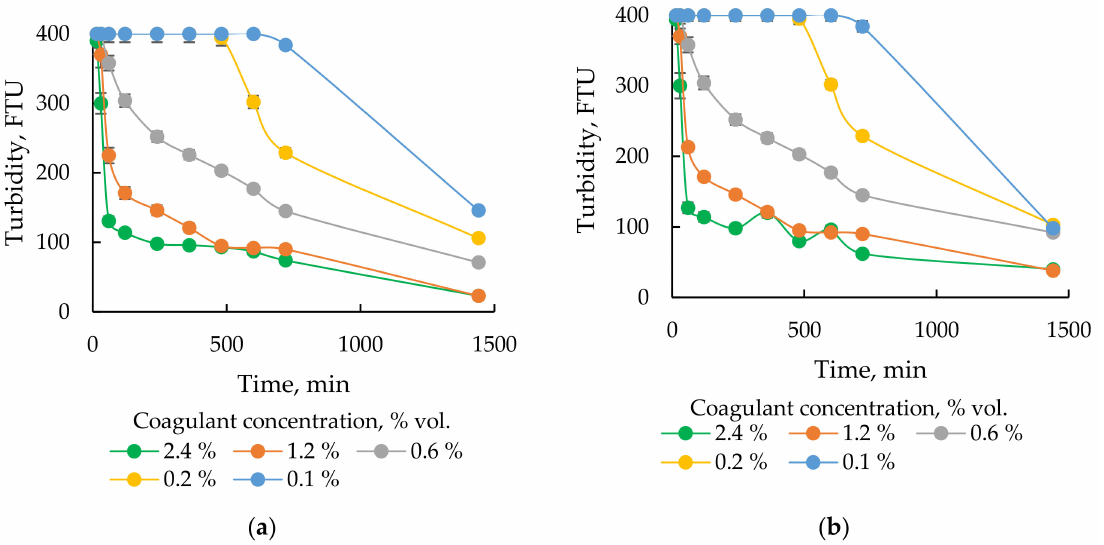
Figure 5. Changes in turbidity depending on the duration of the coagulation process for coagulants ( a ) SAX18 and ( b )